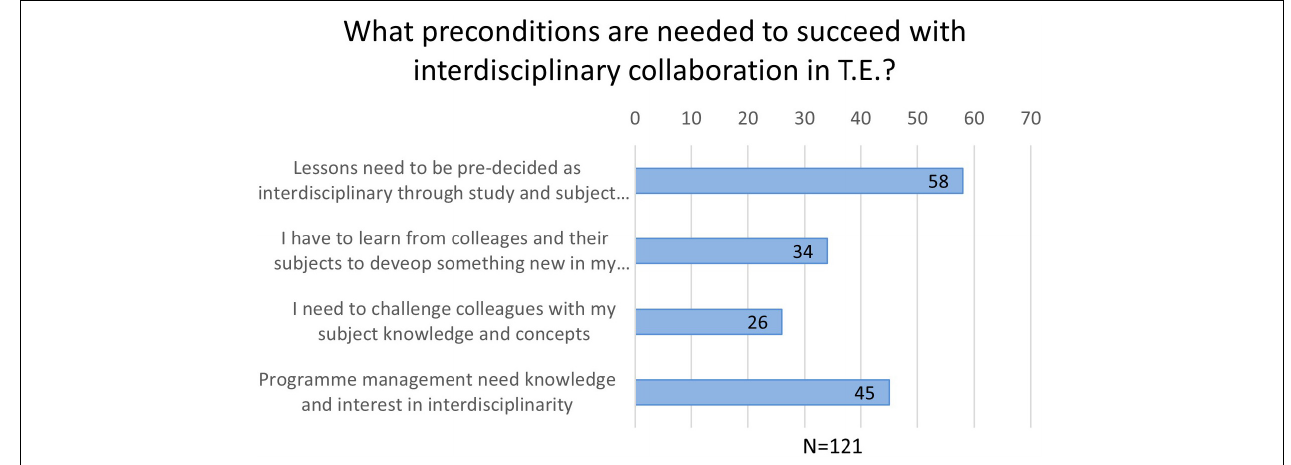
FIGURE 4 | Teacher educators’ report on conditions needed to succeed with interdisciplinary